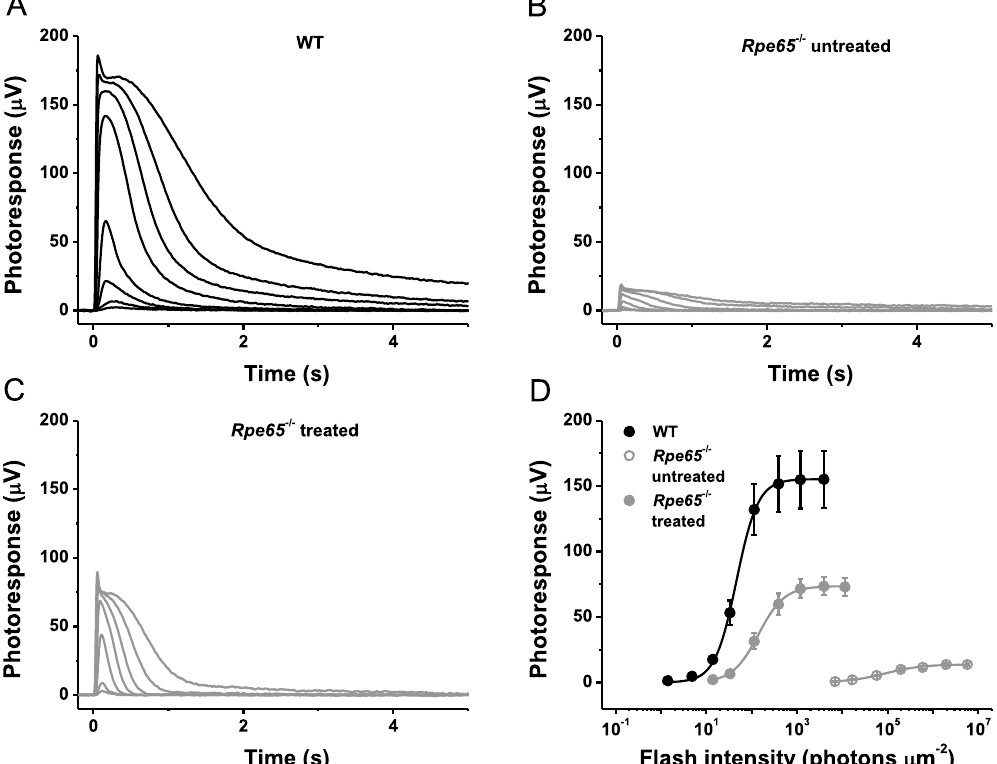
Figure 1. Treatment with 9- cis -retinal largely restores sensitivity of chromophore-deficient mouse rods. ( A ) Representative family of transretinal rod ERG responses from wild-type (C57BL/6J) mouse retinas. Test flashes of 505 nm light with intensities of 1.6, 4.8, 14, 33, 114, 392, 1.2 × 10 3 , and 3.9 × 10 3 photons μ m − 2 were delivered at time 0. ( B ) Representative family of transretinal rod ERG responses from Rpe65 − / − mouse retinas. Test flashes of 505 nm light with intensities of 6.9 × 10 3 , 1.7 × 10 4 , 5.7 × 10 4 , 2.0 × 10 5 , 6.0 × 10 5 , 2.0 × 10 6 , and 5.7 × 10 6 photons μ m − 2 were delivered at time 0. There were no responses if lower flash intensities were applied. ( C ) Representative family of transretinal rod ERG responses from retinas of Rpe65 − / − animals repeatedly injected with 9- cis -retinal and Matrigel R Matrix. Test flashes of 505 nm light with intensities of 14, 33, 114, 392, 1.2 × 10 3 , 3.9 × 10 3 , and 1.1 × 10 4 photons μ m − 2 were delivered at time 0. ( D ) Averaged rod intensity-response functions (mean ± SEM) for wild-type (n = 3), Rpe65 − / − (n = 4), and 9- cis -retinal treated Rpe65 − / − (n = 7) mice. Error bars for some points are smaller than the symbol size. Hyperbolic Naka-Rushton fits yielded half-saturating intensities ( I 1/2 ) of 46, 8.9 × 10 4 , and 142 photons μ m − 2 ,